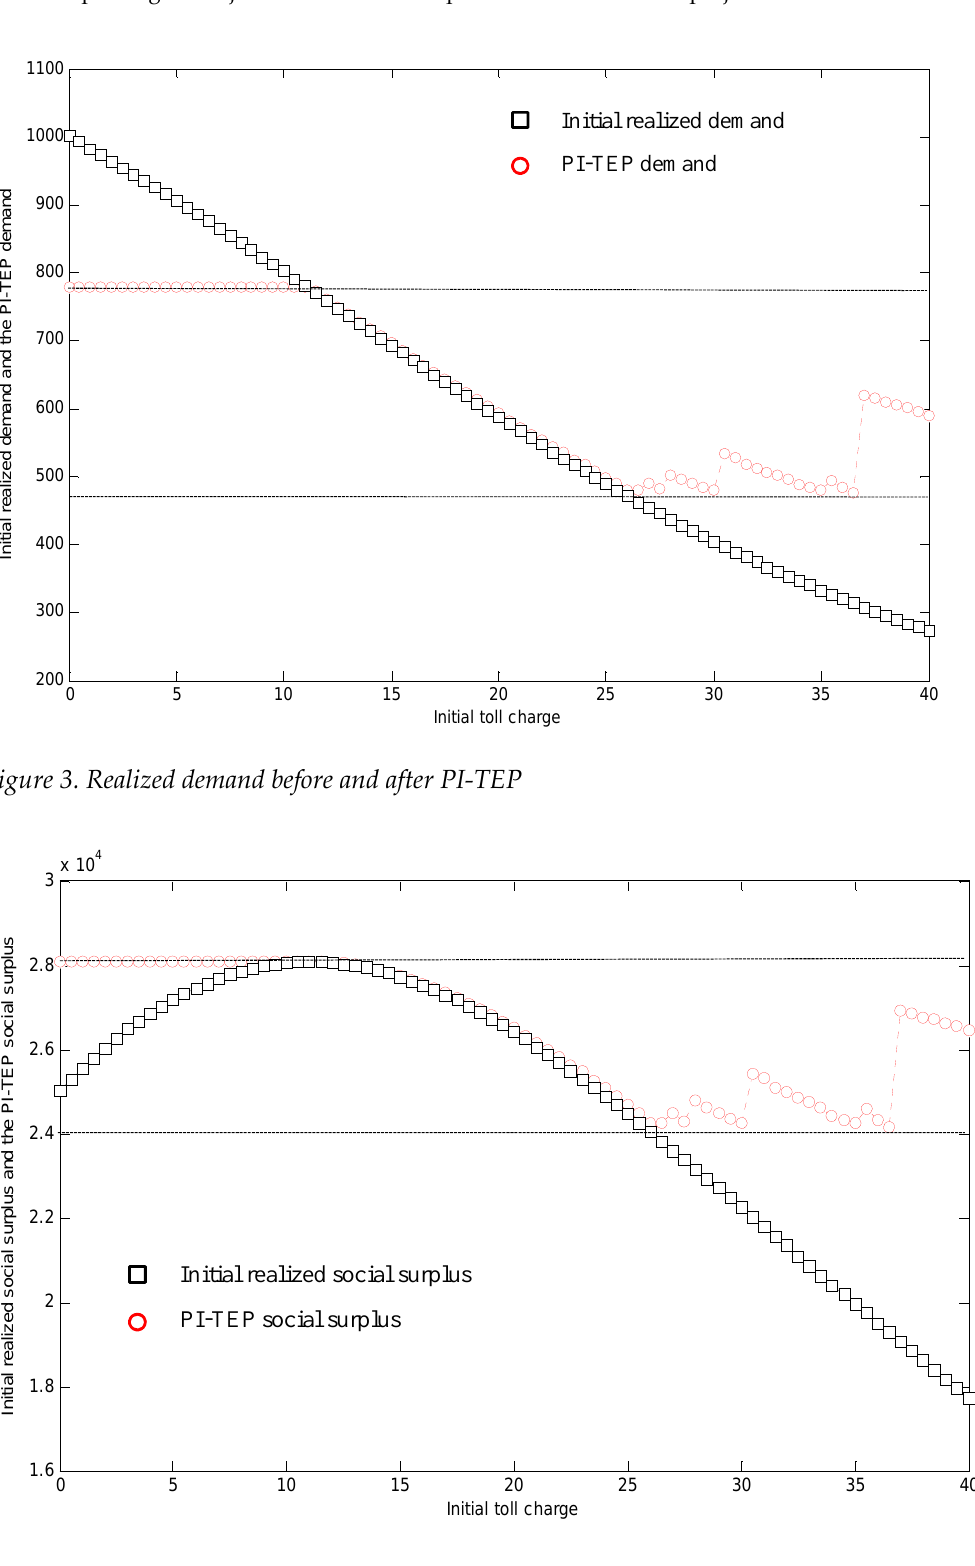
Figure 4. Realized social surplus before and after